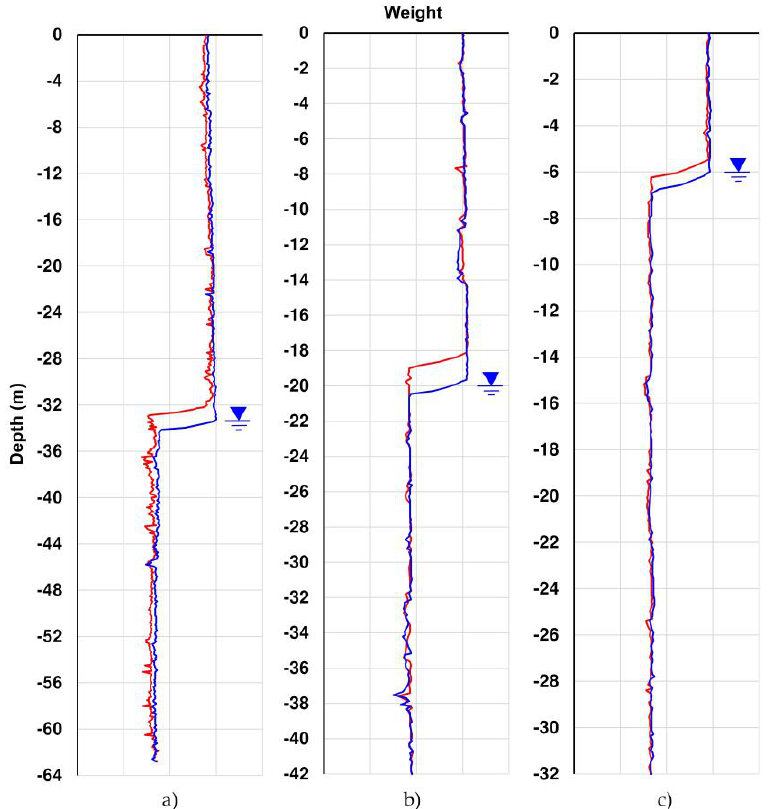
tube (Sections 1–3).